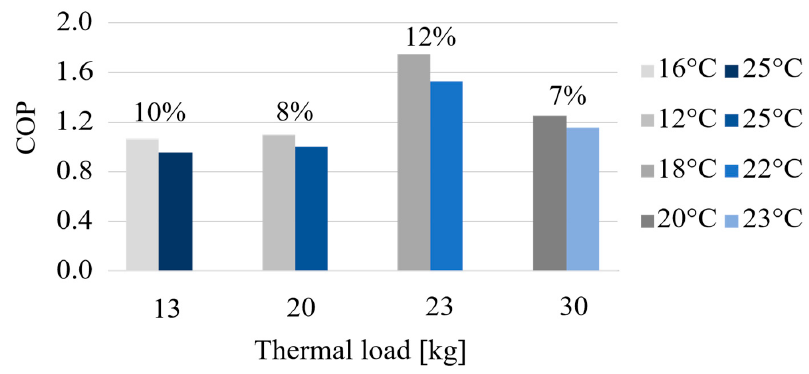
Figure 10. Coefficient of performance at different conditions of ambient temperature. 359